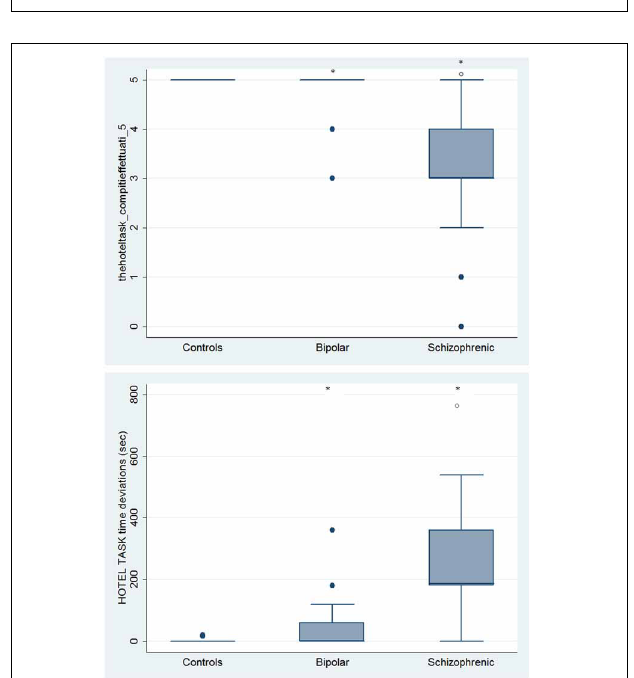
FIGURE 11 | Differences between groups in ESCB tasks: HOTEL Task Attempted and Time deviations. • Outliers. ∗ Significantly different from HC ( p < 0 . 05). ◦ Significantly different from BD ( p < 0 .